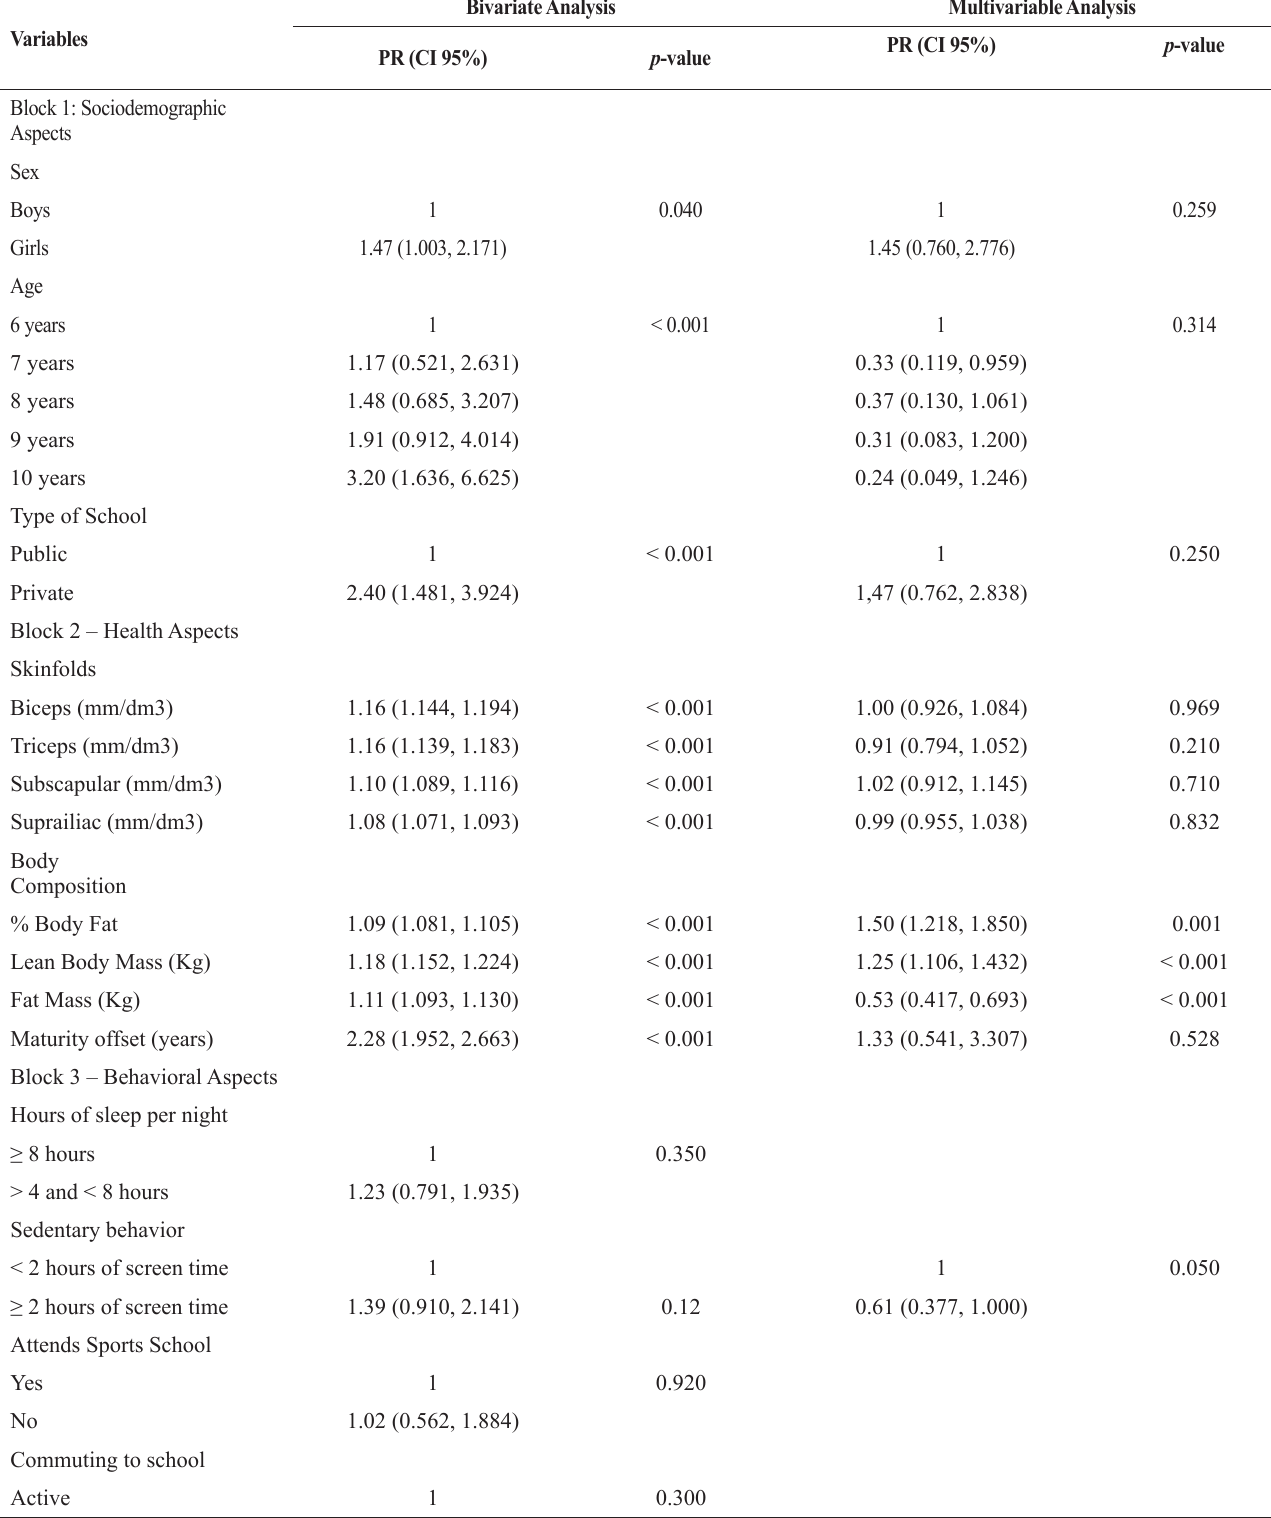
Table 2. Factors Associated with Metabolic Syndrome in children aged 6-10 years old Bivariate Analysis Multivariable Variables